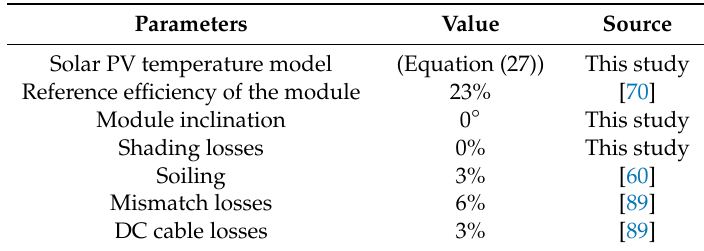
Table 1. Energy modeling simulation